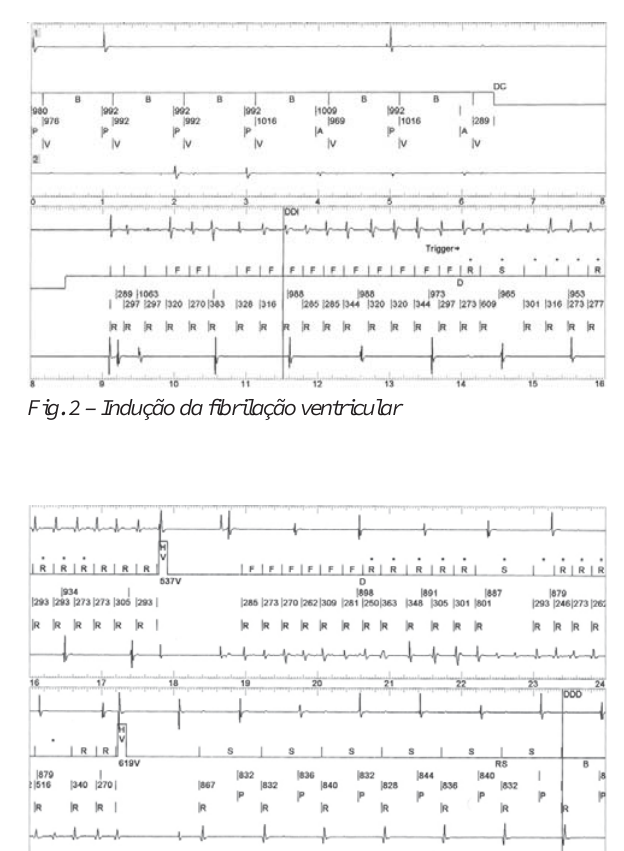
Costa R, et al. Diretrizes para o implante de cardioversor desfibrilador implantável. Arq Bras Cardiol. 2000;74(5):481-2. 2. Chin TK, Perloff JK, Williams RG, Jue K, Mohrmann R. Isolated noncompaction of left ventricular myocardium. A study of eight cases. Circulation.